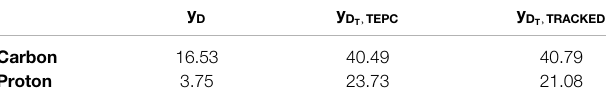
values T , TCEP ) and T